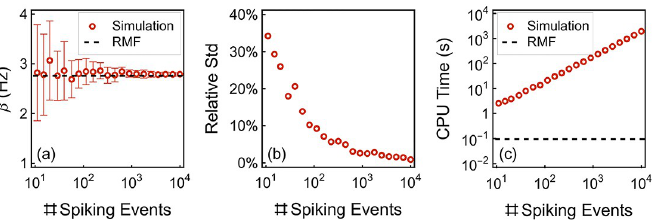
Fig 4. Computational efficiency of the RMF method. Panel (a) shows the spiking rates of a single neuron subjected to a fixed excitatory input with β e = 1 kHz and μ e = 1. The black dashed line indicates the RMF calculations of the rate. The red circles and error bars indicate the simulated mean and standard deviation of the spiking rate computed from different numbers of spiking events. Specifically, we run the event-driven simulation until N spiking events for the single neuron are accumulated. This process is repeated for 32 times. During each repetition, we record the total time T firing rates of the neuron are then computed by � b ¼ ð by error bars) over these 32 repetitions are computed by taking the square root of ð Panel (b) shows the relative standard deviations of the simulated rates. The relative standard deviations are computed by Std ð b Þ = � b . Panel (c) shows the CPU time consumed for simulating different numbers of spiking events with 32 repetitions (red circles), together with the CPU time of the RMF calculation (black dashed line). The simulation platform is a 2021 MacBook Pro with Apple M1 Pro chip. Parameters: τ = 10 ms, h = 1 Hz, a =